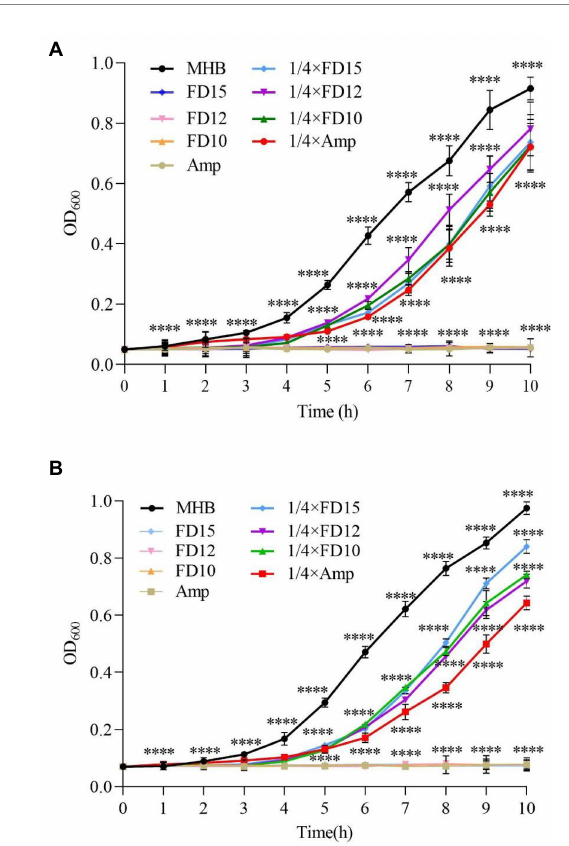
FIGURE 2 Dynamic antimicrobial analysis of the effects of antimicrobial peptides (AMPs) FD10, FD12, and FD15 against (A) E. coli ( n = 3) and (B) S. aureus CMCC(B) 26003 ( n = 3). Cells were treated with 1× and 1/4× MIC FD10, FD12, or FD15, with MHB and ampicillin (Amp) as the positive control. The statistical significance of differences was determined using the two-way ANOVA for (A) and (B) . (*) indicates the significance between Amp, FD10, FD12, FD15 and MHB, **** p < 0.0001.